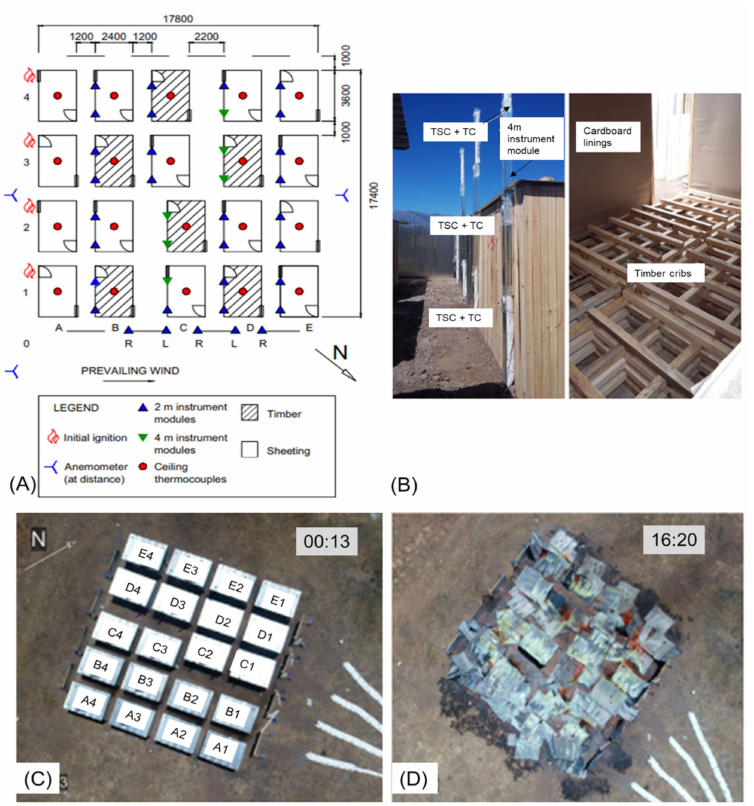
Figure 3. Full-scale fire test on 20 informal dwellings. ( A ) Experiment layout, ( B ) instrumentation and fuel load arrangement, ( C ) aerial image of fire experiment soon after ignition, ( D ) image of fire experiment at 16 min 20 s